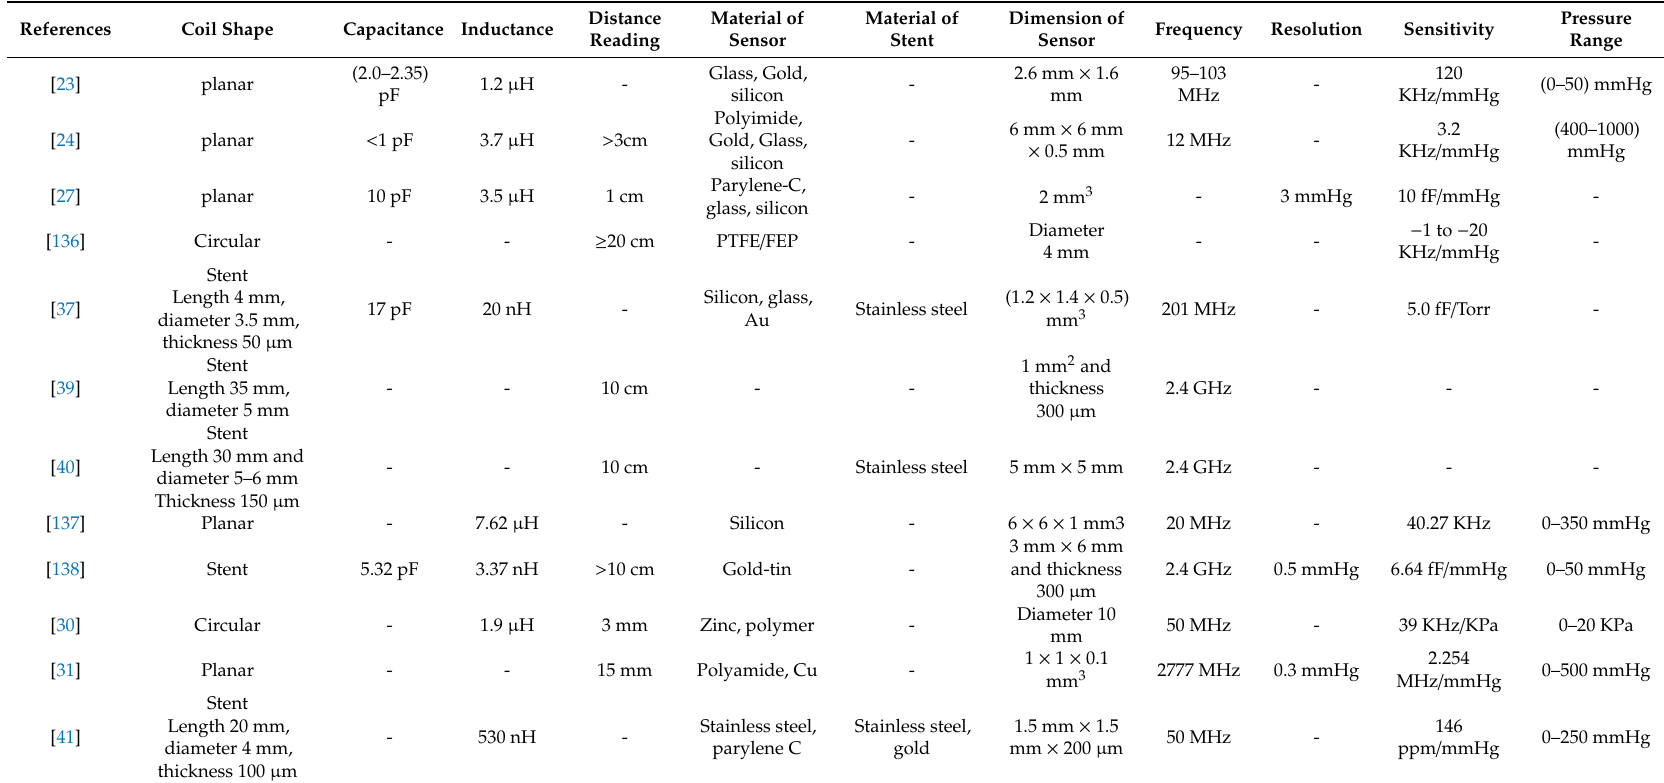
Table A1. This is a table show the performance of pressure